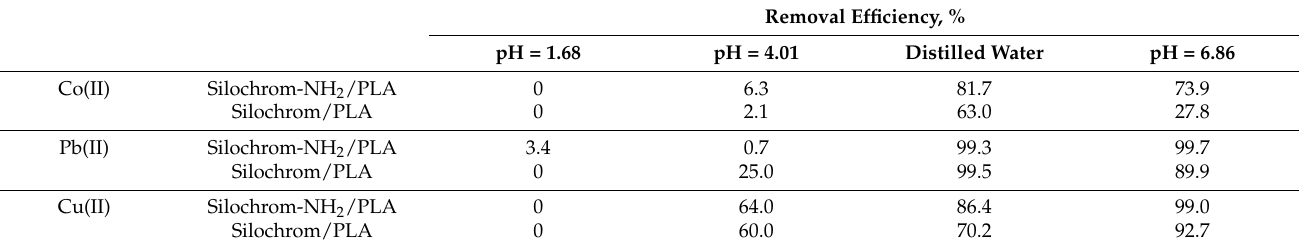
Table 2. The pH-dependent values of the maximum separation degree of Pb(II), Co(II), and Cu(II) ions by modified composites at the static mode of adsorption (Experimental conditions: mass of sorbent—0.1 g, the volume of the solution—25 mL, metal content in the solution —100 µ g). Removal Efficiency, % pH = 1.68 pH = 4.01 Distilled Water pH = 6.86